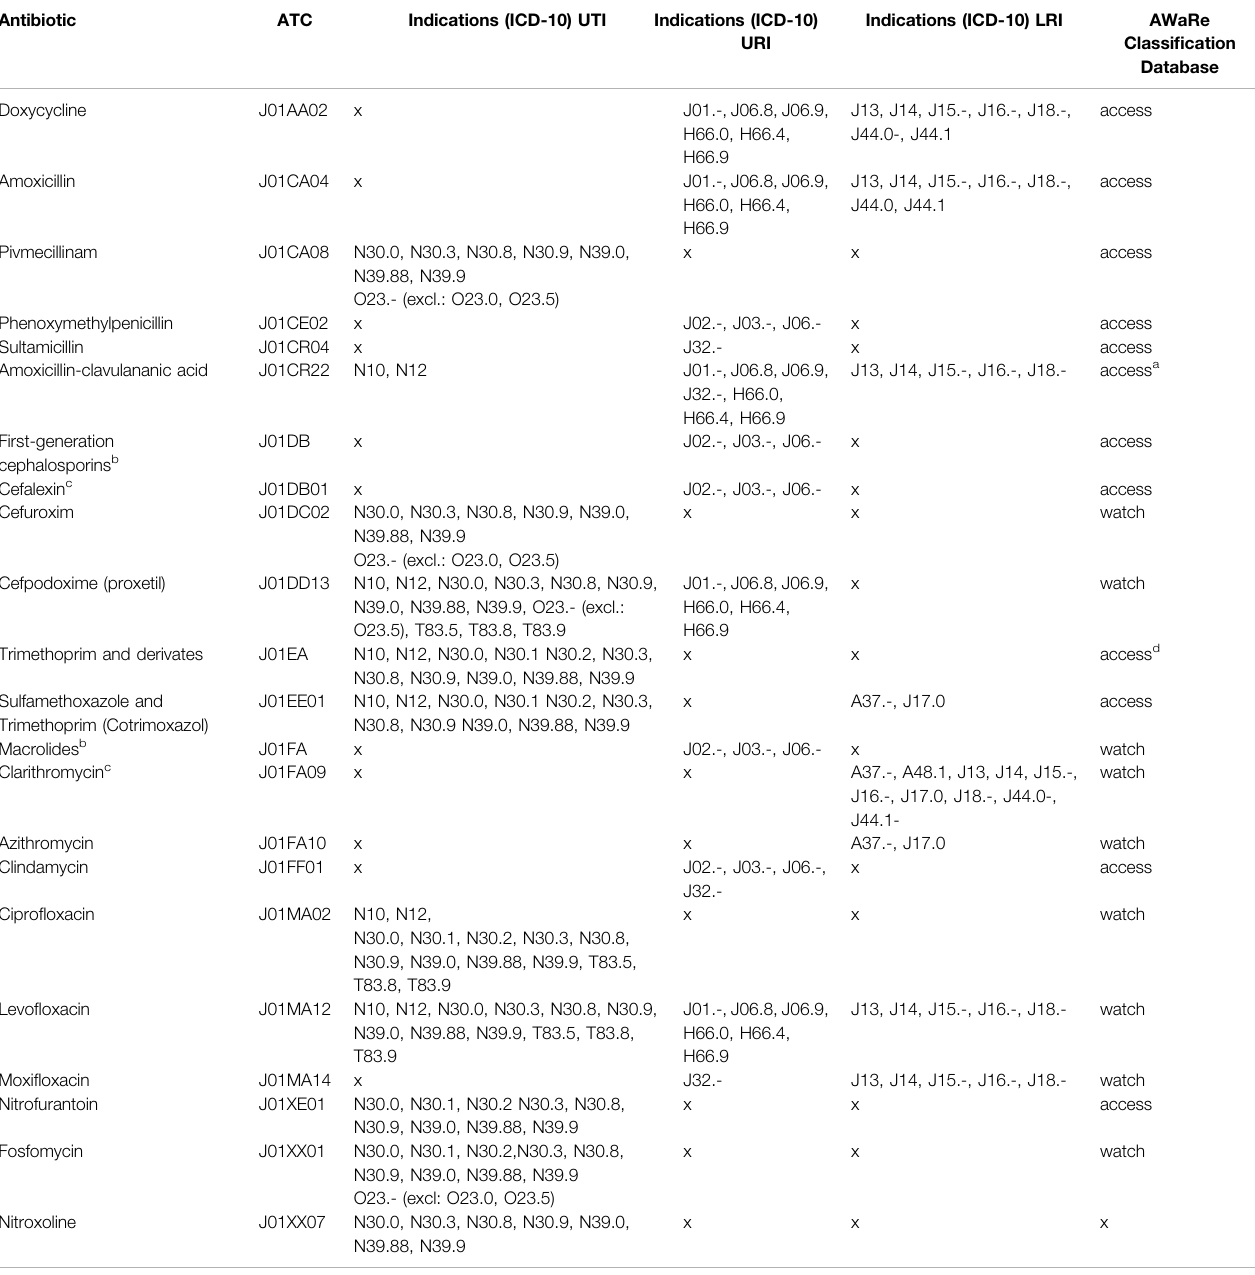
The table is based on the of fi cial ATC index 2017 available at dimdi.de and sorted accordingly. “ x ” denotes that the antibiotic is not indicated for this group of diagnoses. a ATC code J01CR22 existed 2016 – 2018. b Whole class of antibiotics correct for the listed indications according to the training material. c Belonging to a class of antibiotics but speci fi cally mentioned in the training material. d Classi fi cation “ Access ” only valid for